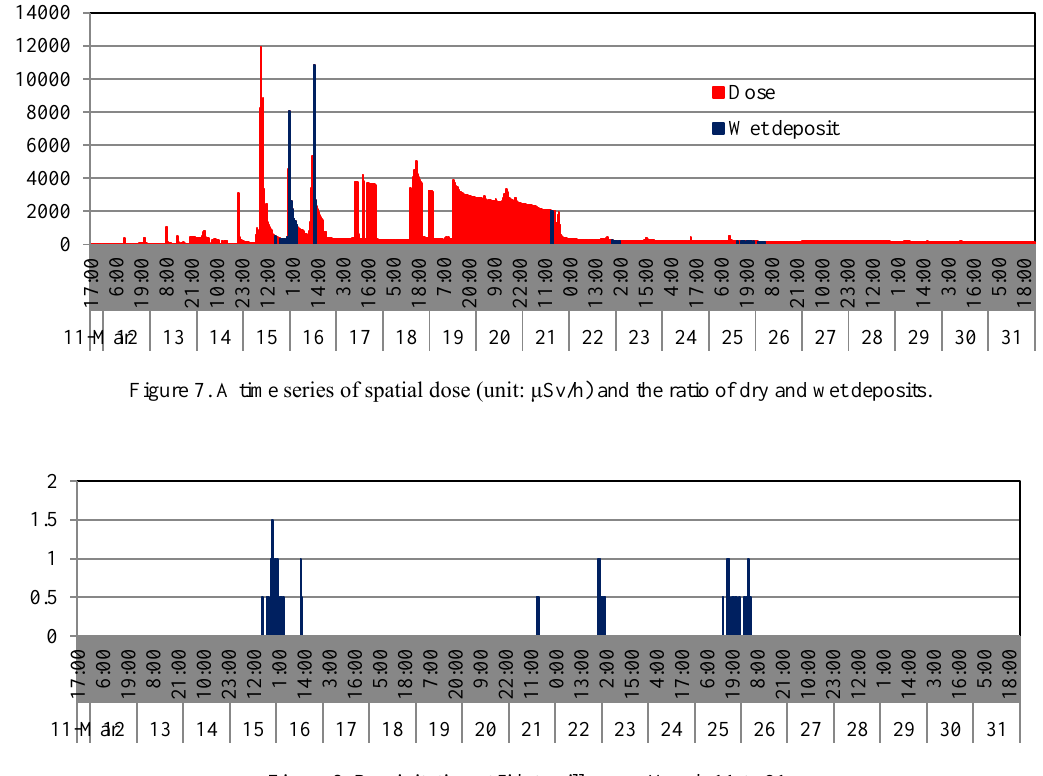
Figure 8. Precipitation at Iidate village on March 11 to